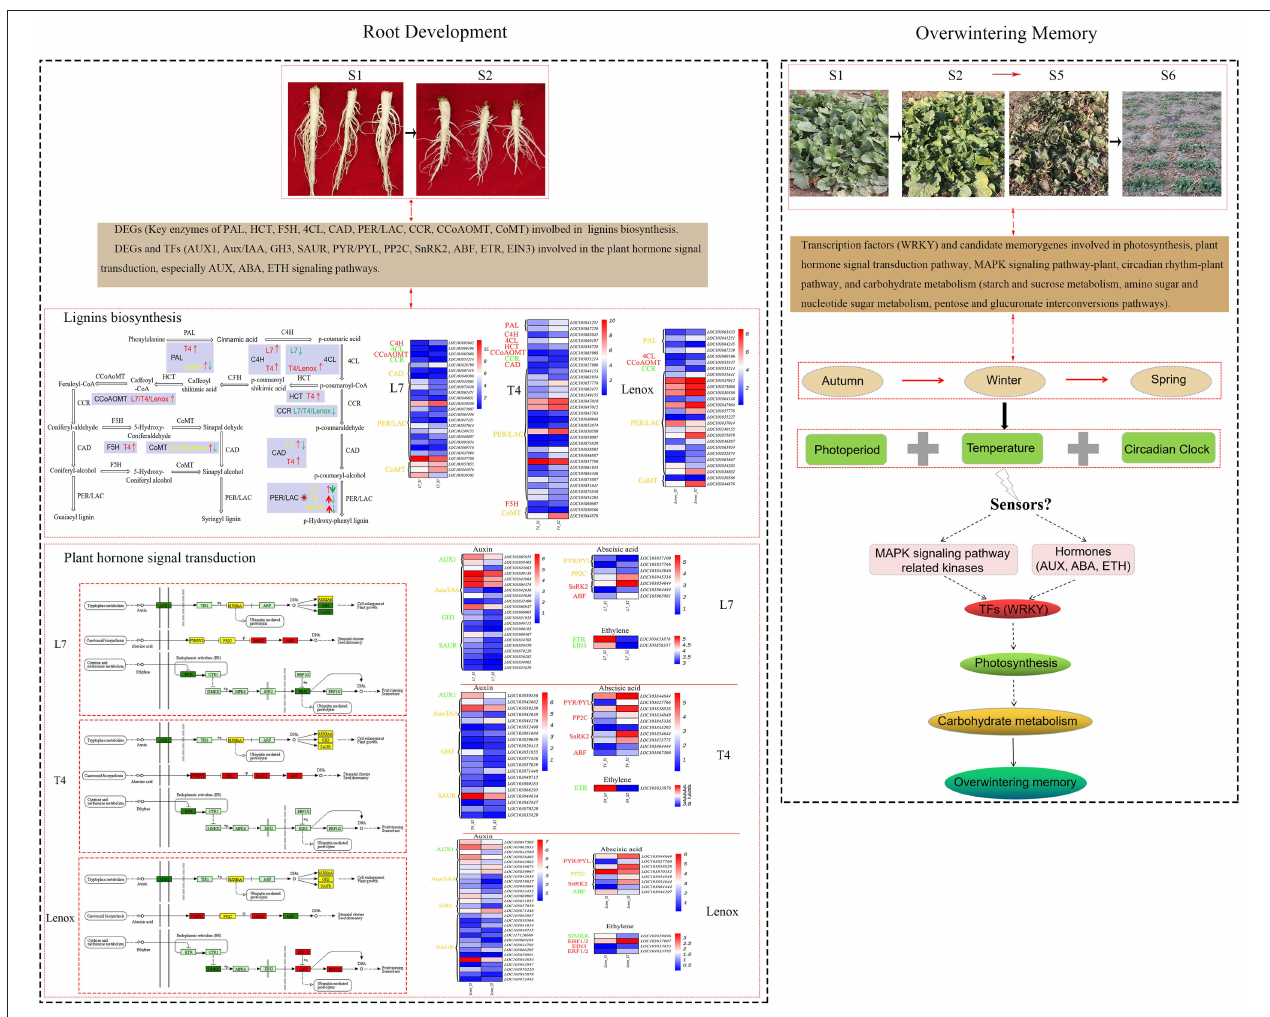
FIGURE 8 | Presumed molecular regulation network underlying root development and overwintering memory in winter rapeseed. The upregulated DEGs annotated in KEGG map and heatmaps were highlighted with red color, the downregulated DEGs were highlighted with green color, and yellow indicates both downregulated and